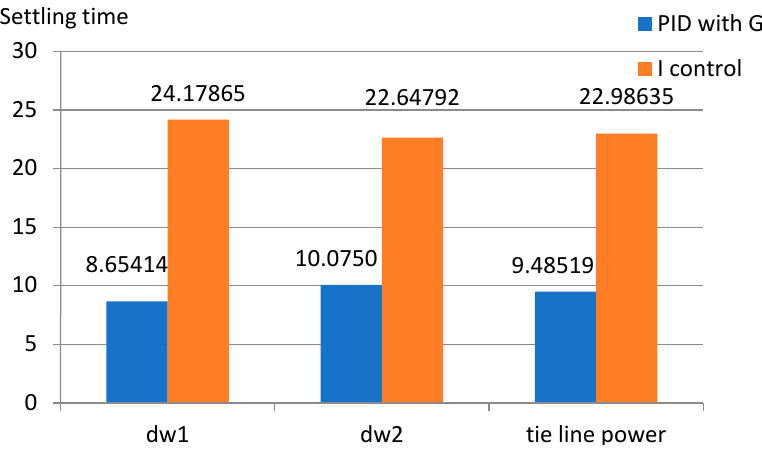
Figure 10. Settling time variations in I and PID controllers.